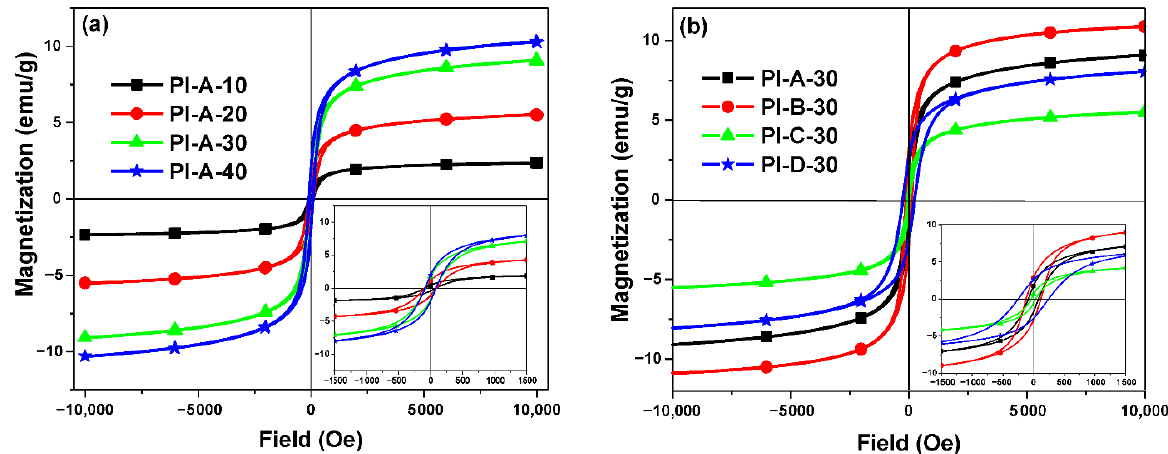
Figure 4. Hysteresis curves of PI-A-10, PI-A-20, PI-A-30, and PI-A-40, ±10 kOe representation—main figure, ±1.5 kOe— bottom right plot ( a ) and of PI-A-30, PI-B-30, PI-C-30, and PI-D-30, ±10 kOe representation—main figure, ±1.5 kOe—bottom right plot ( b ).